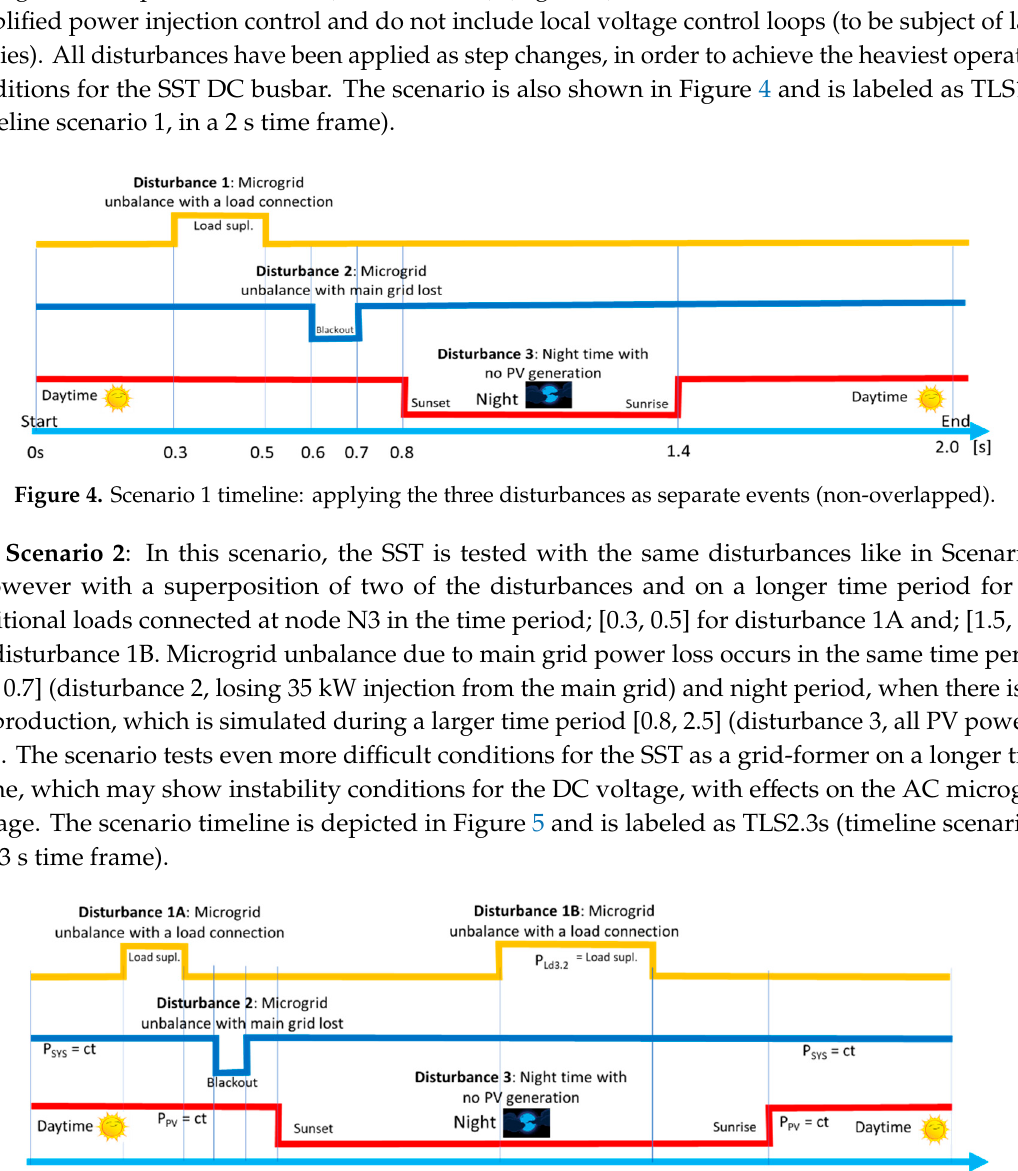
Figure 6. Simplified microgrid for longer term stability analysis.